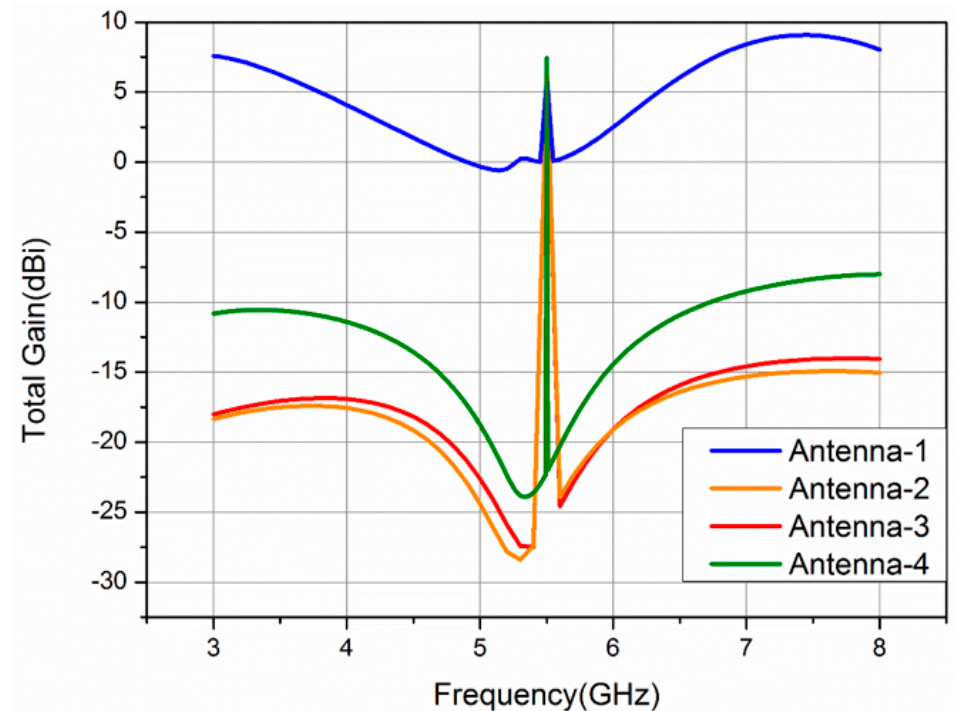
Figure 7. Directivity of Antenna-1, Antenna-2, Antenna-3, and Antenna-4.